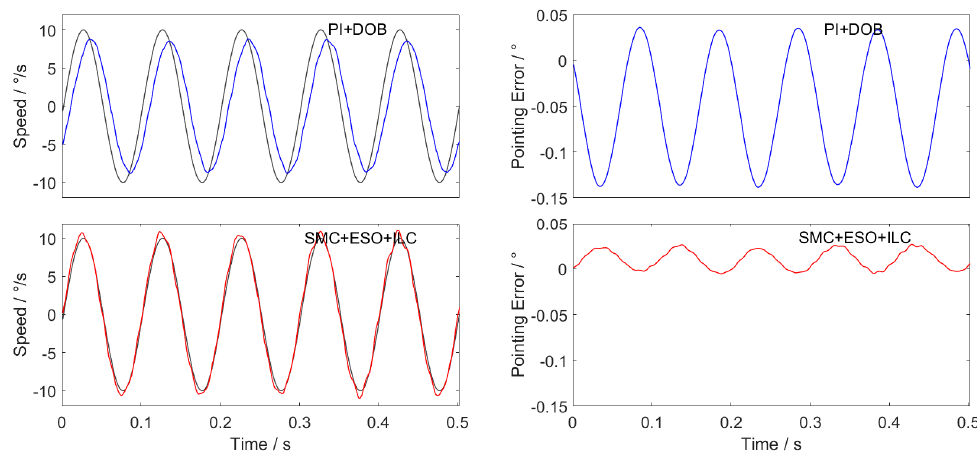
Figure 12. Uniform speed tracking curve and position pointing error.